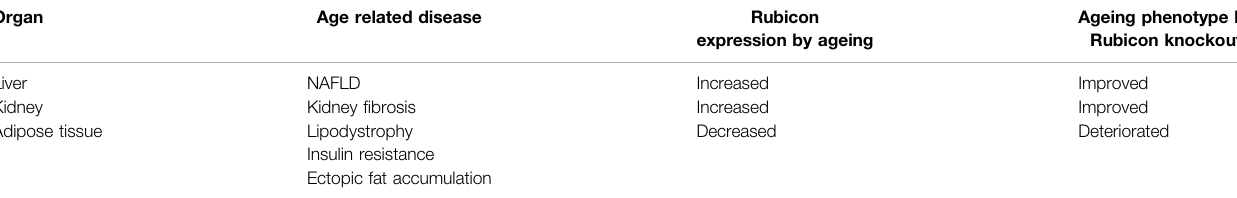
TABLE 1 | Differential expression and role of Rubicon in various organs during ageing.